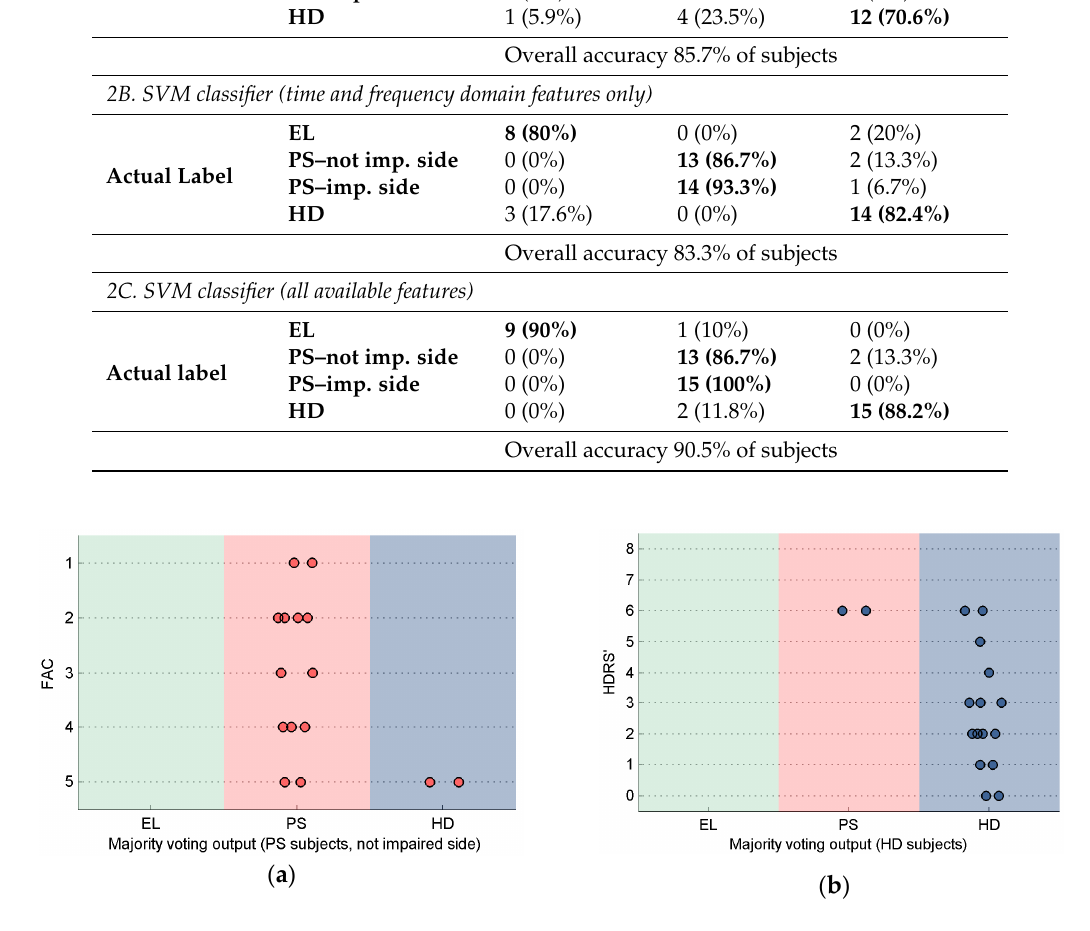
Figure 4. Output of the classifier after MV in relation to clinical scales: ( a ) PS subjects (impaired side only), in relation to the FAC scale. No data were misclassified from the PS class to the EL class. Two subjects are misclassified from the PS class to the HD class; ( b ) HD subjects in relation to the HDRS’ scale. No data were misclassified from the HD class to the EL class. Two subjects were misclassified from the HD class to the PS class.